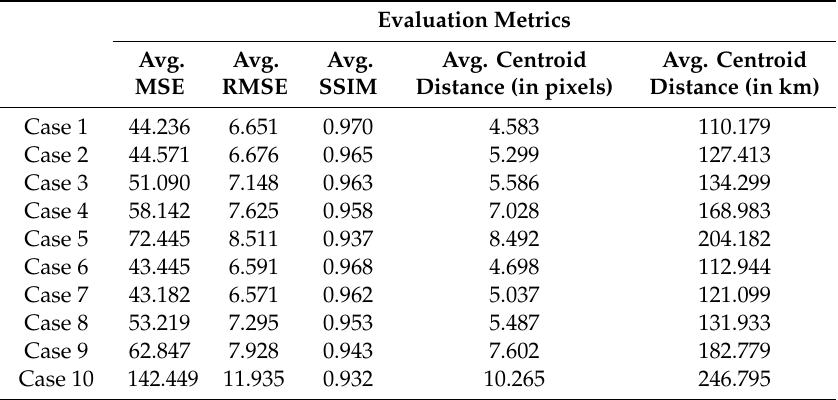
Table 7. MSE, RMSE, SSIM, and centroid distance measure